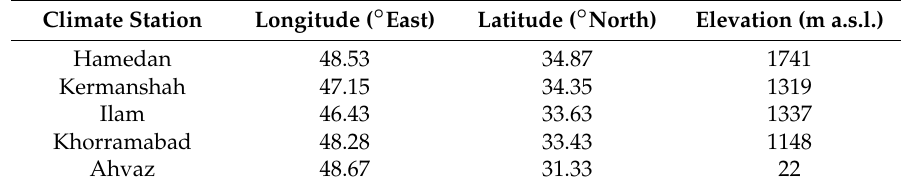
Table 1. Geographical characteristics of the selected climate stations. Climate